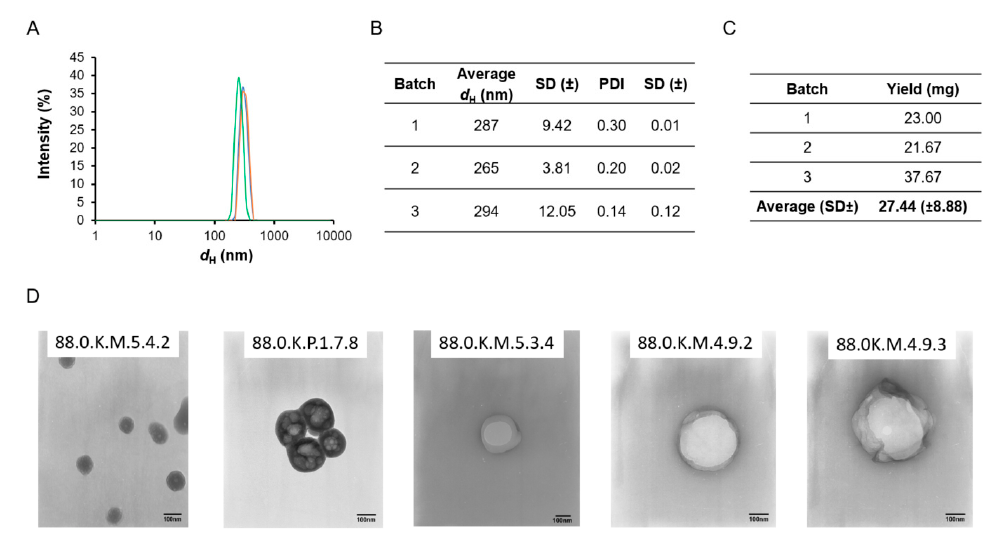
Figure 1. ( A ) Typical intensity (%) results of nanoMIPs and ( B ) Average (SD ± ) of dH (nm) and PDI (SD ± ) of each nanoMIP batches obtained during DLS analysis. ( C ) Results of yield (expressed in mg) obtained across the three batches. ( D ) Typical BLG nanoMIP morphology obtained by TEM analysis (650,000–880,000 × ) (The size bars are equal to 100 nm).